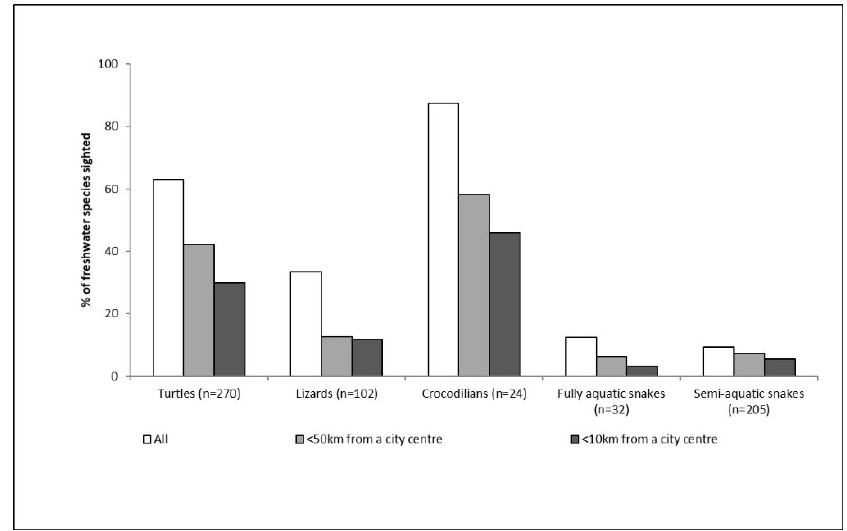
Figure 7. Percentage of freshwater species in each reptile group, sighted between January 2013 and April 2018. The unshaded bars represent the percentage of all known species in the group, sighted during that period anywhere in the world. The light gray and dark gray bars represent the percentage of known species sighted within 50 and 10 km of the center of a city.